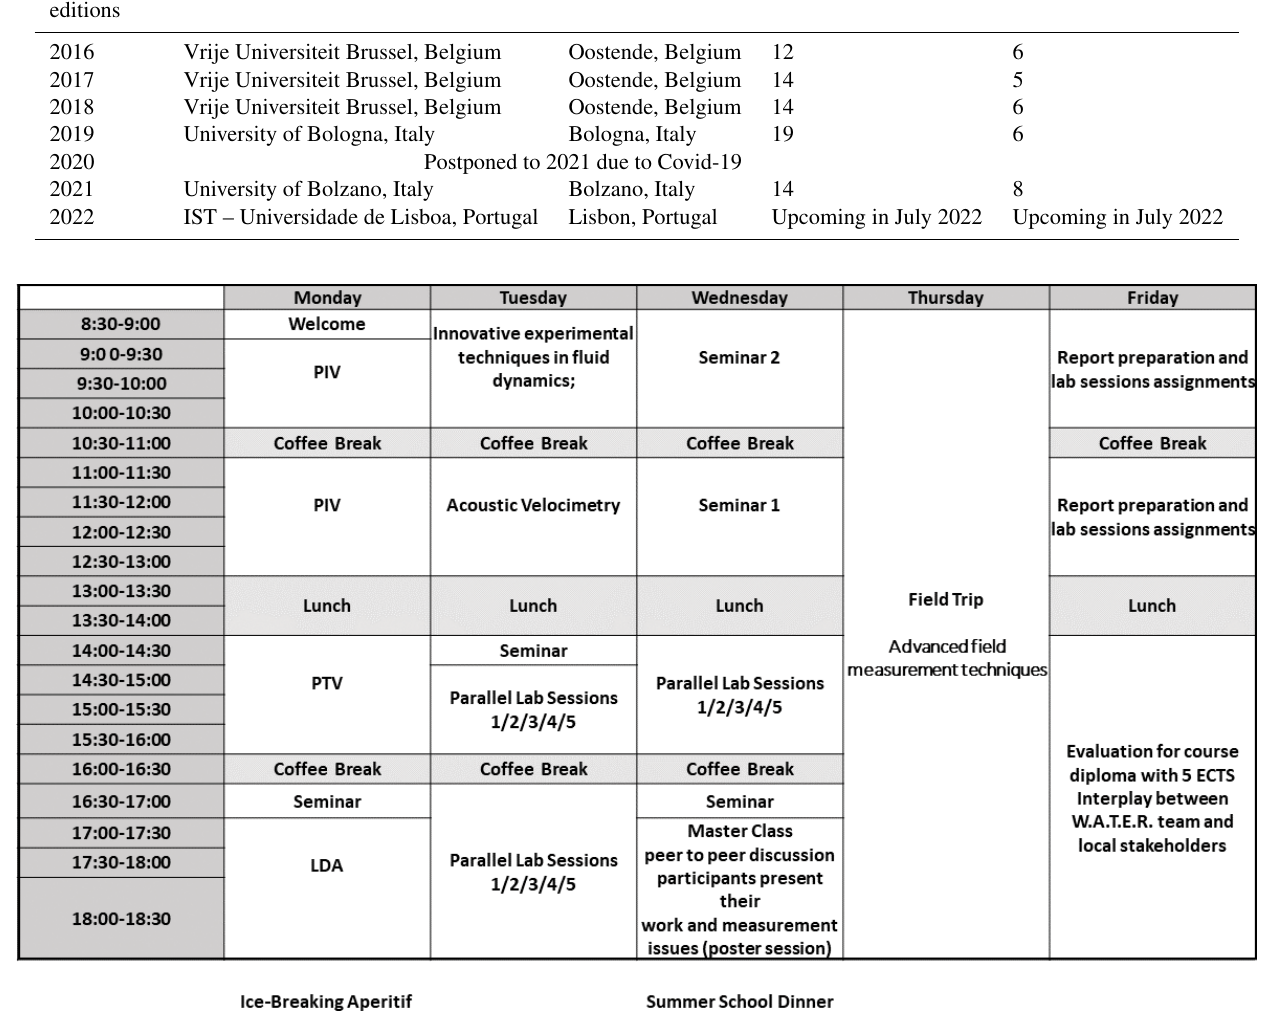
Figure 1. Typical schedule of W.A.T.E.R.